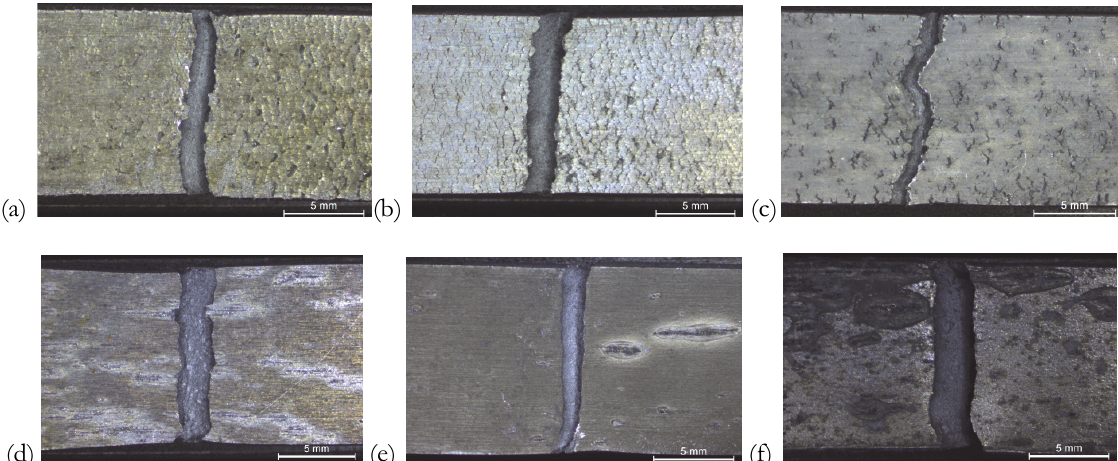
Figure 4: Typical photographs of AA2024-T3 pre-corroded tensile specimens exposed to the EXCO solution (a)-(c) for 2 h, 4 h and 24 h, respectively and 3.5 wt. % NaCl solution (d)-(f) for 6 h, 168 h and 720 h,